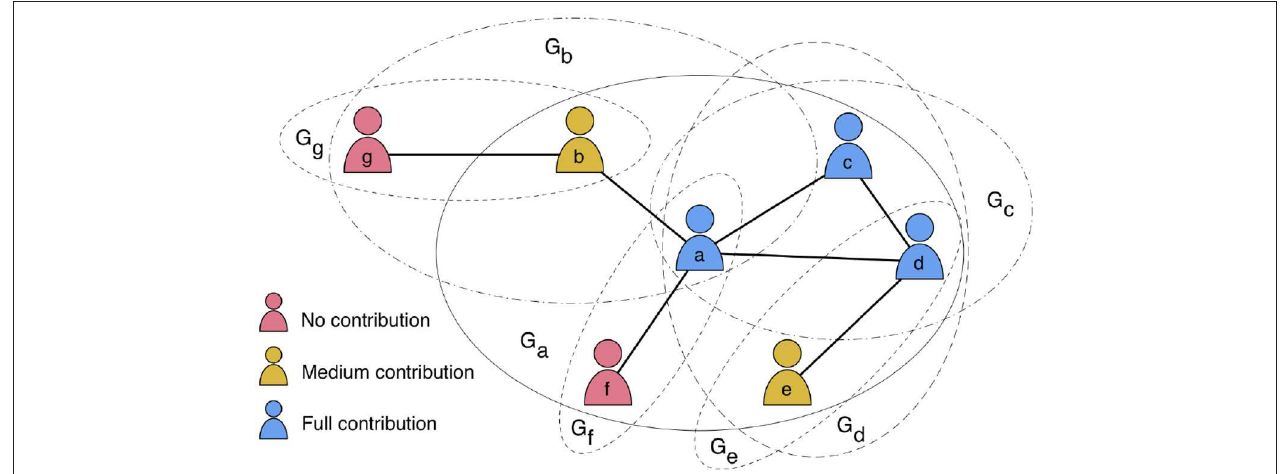
FIGURE 1 | Visual representation of public goods games played on a network structure of seven nodes. Each PGG is centered in a focal node i and it is represented by a circle G i . For example, the node a has four direct neighbors ( b , c , d , f ) and it participates in five PGGs, i.e., the circle G a centered in a including its four neighbors, and other four PGGs represented by circles centered in its neighbors: G b , G c , G d , G f . Note that a node may indirectly interact with other nodes that are not direct neighbors. Colors represent the node contribution into the common pools in which it participates.